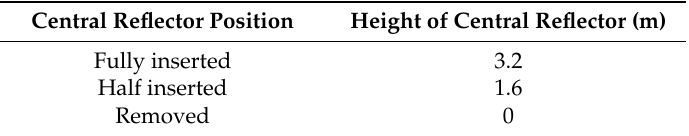
Table 1. CenRef positions considered. Table 1 . CenRef positions considered.